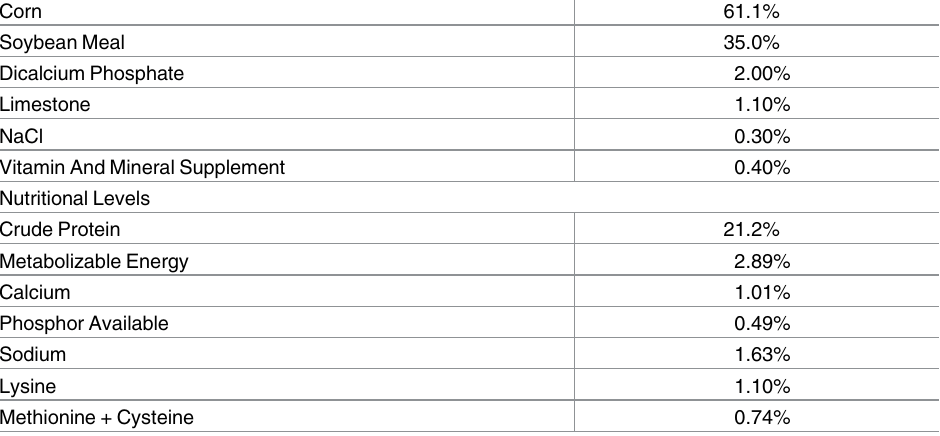
Table 1. Initial feed used in the production of chicks up to 30 days of age (ROSTAGNO, GOMES,